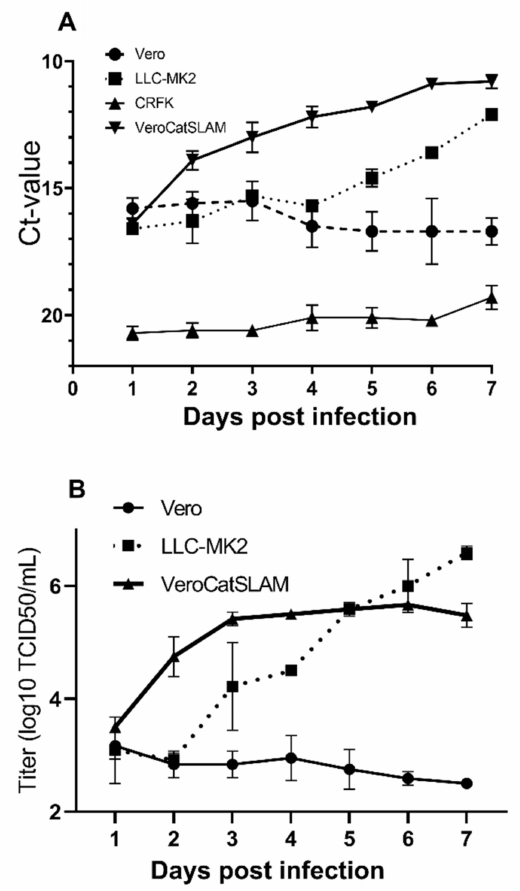
Figure 1. Replication of FeMV-GT2 in vitro. ( A ) Seven-day kinetics of specific FeMV Gordon strain RNA measured by RT-qPCR on LLC-MK2, CRFK, Vero, and VeroCatSLAM cells. Mean values of two distinct experiments and the standard deviation are shown. ( B ) Seven-day kinetics of FeMV replication (TCID 50 ) on LLC-MK2, Vero, and VeroCatSLAM cells. Mean values of two distinct experiments and the standard deviation are